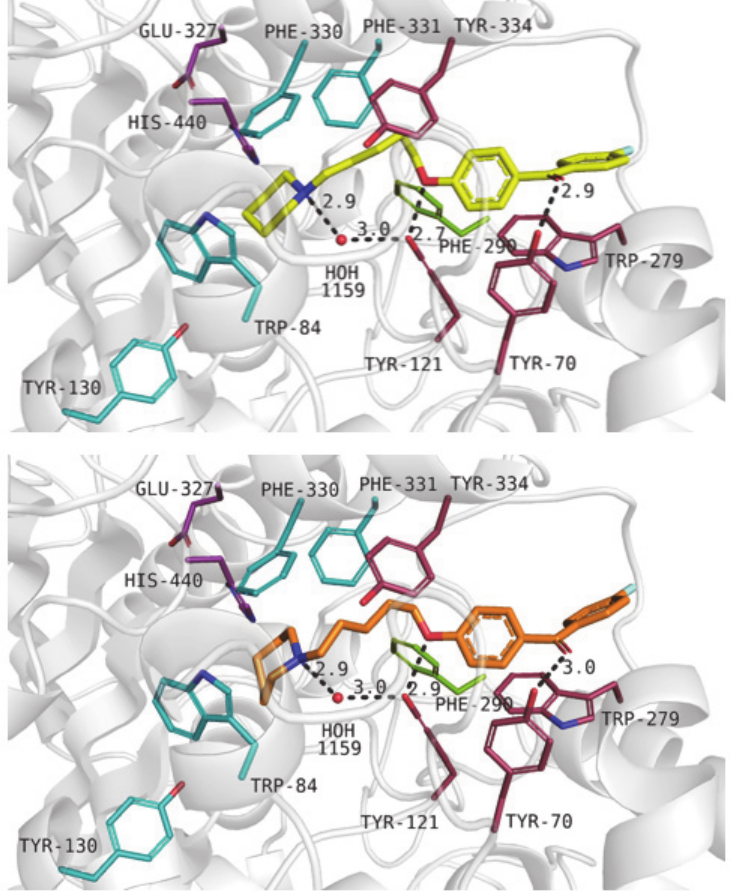
Figure 8. Binding modes of compound 30 ( upper panel ) and 6 ( lower panel ) within the acetylcholinesterase active site. Residues colored in purple—catalytic triad, blue—anionic site, pink—peripheral anionic site, green—acyl pocket.